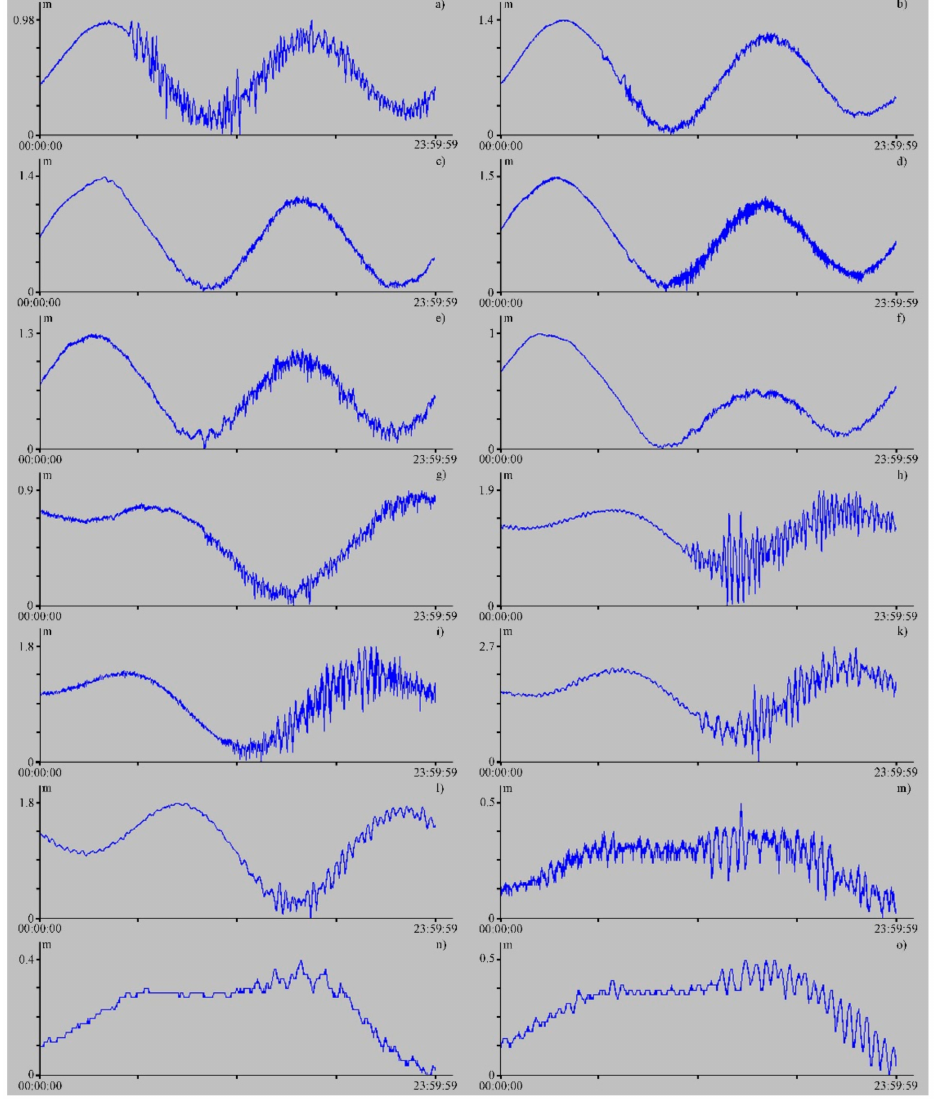
Figure 10. Record fragments of sea-level meters at stations: ( a ) Apia Upolu WS, ( b ) Fongafale p, ( c ) Betio Tarawa, ( d ) Nauru, ( e ) Kwajalein, ( f ) Dekehtik Pohnpei, ( g ) Saipan, ( h ) Chichijima, ( i ) Mera, ( k ) Tosashimizu, ( l ) Naha, ( m ) Preobrazhenije, ( n ) Pos’et, ( o ) Vladivostok. For 15 January 2022,